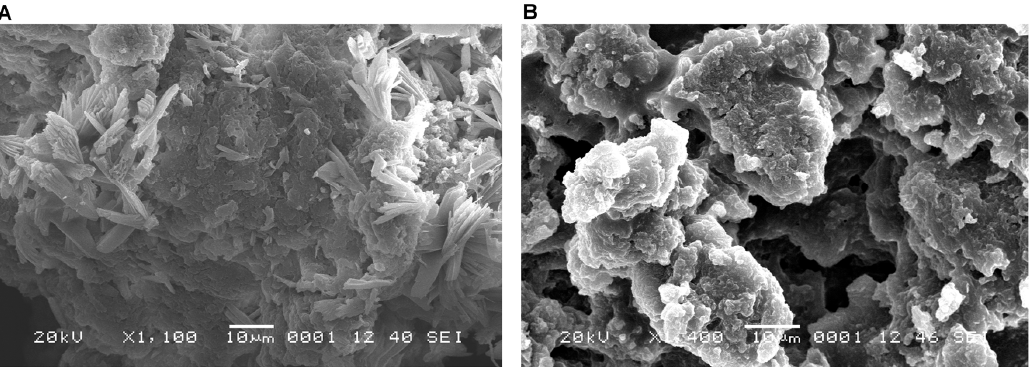
Figure 6. Scanning electron microscopy (SEM) images of the latex from healthy ( A ) and PMeV-infected papaya fruits ( B ). The samples of healthy plants’ latex shows more united and compact latex particles than those from infected plants, which appeared relatively sparse.